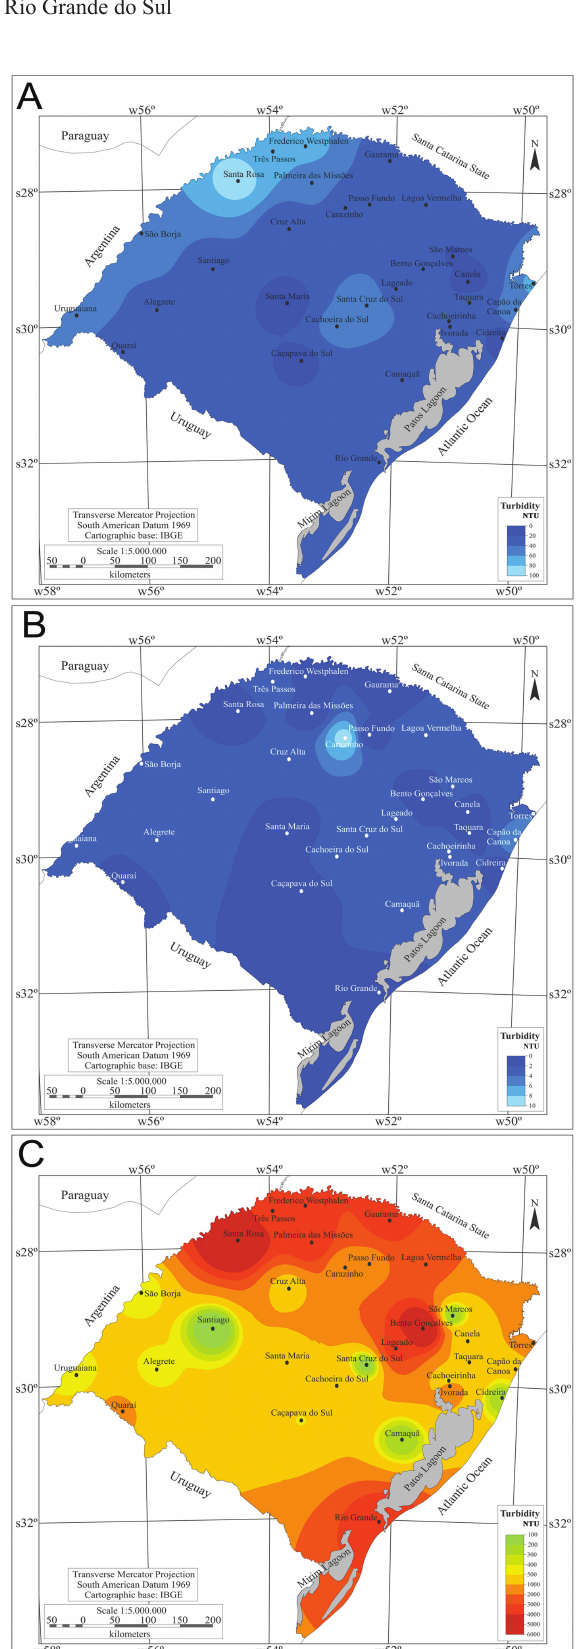
Fig. 3. Water alkalinity in different cities of Rio Grande do Sul in the period of 1996 to 2011 (A) mean, (B) minimum and (C) maximum values (Source CORSAN/RS).